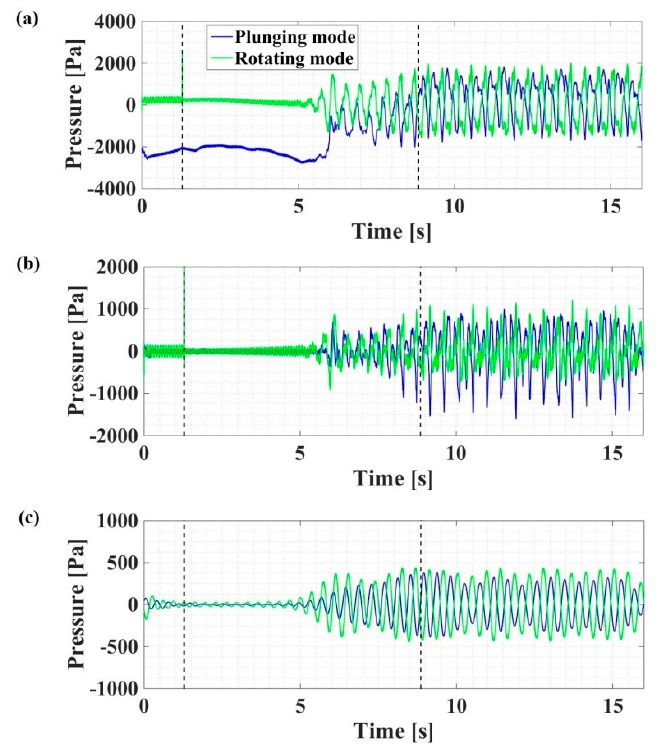
Figure 15. ( a ) RVR components—raw signal. ( b ) Savitzky–Golay filtered pressure signal. ( c ) Truncated pressure signal. The y-scales are different for the three plots.